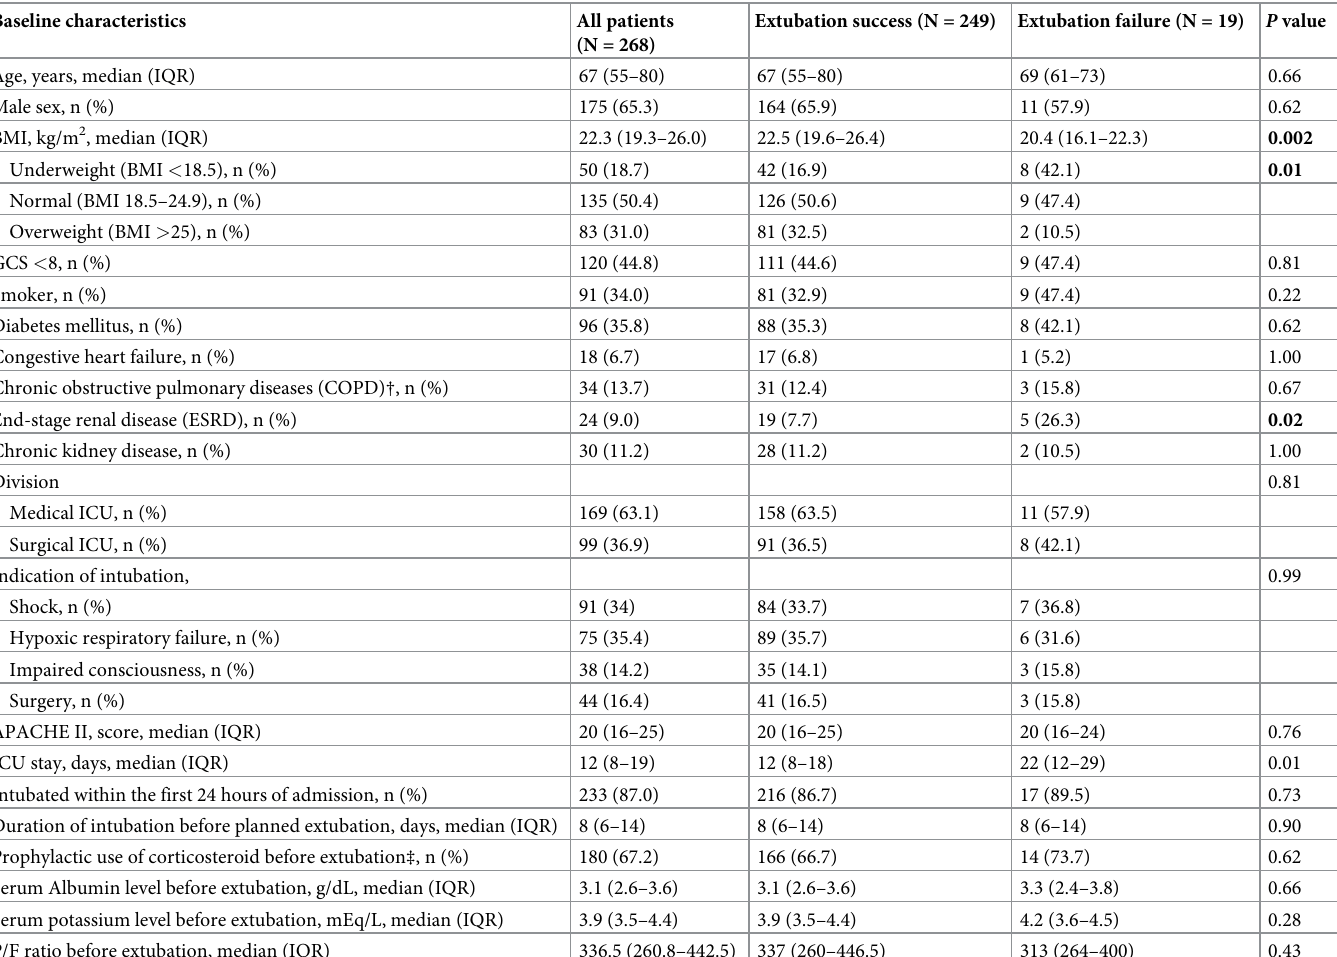
Table 1. Baseline characteristics of enrolled